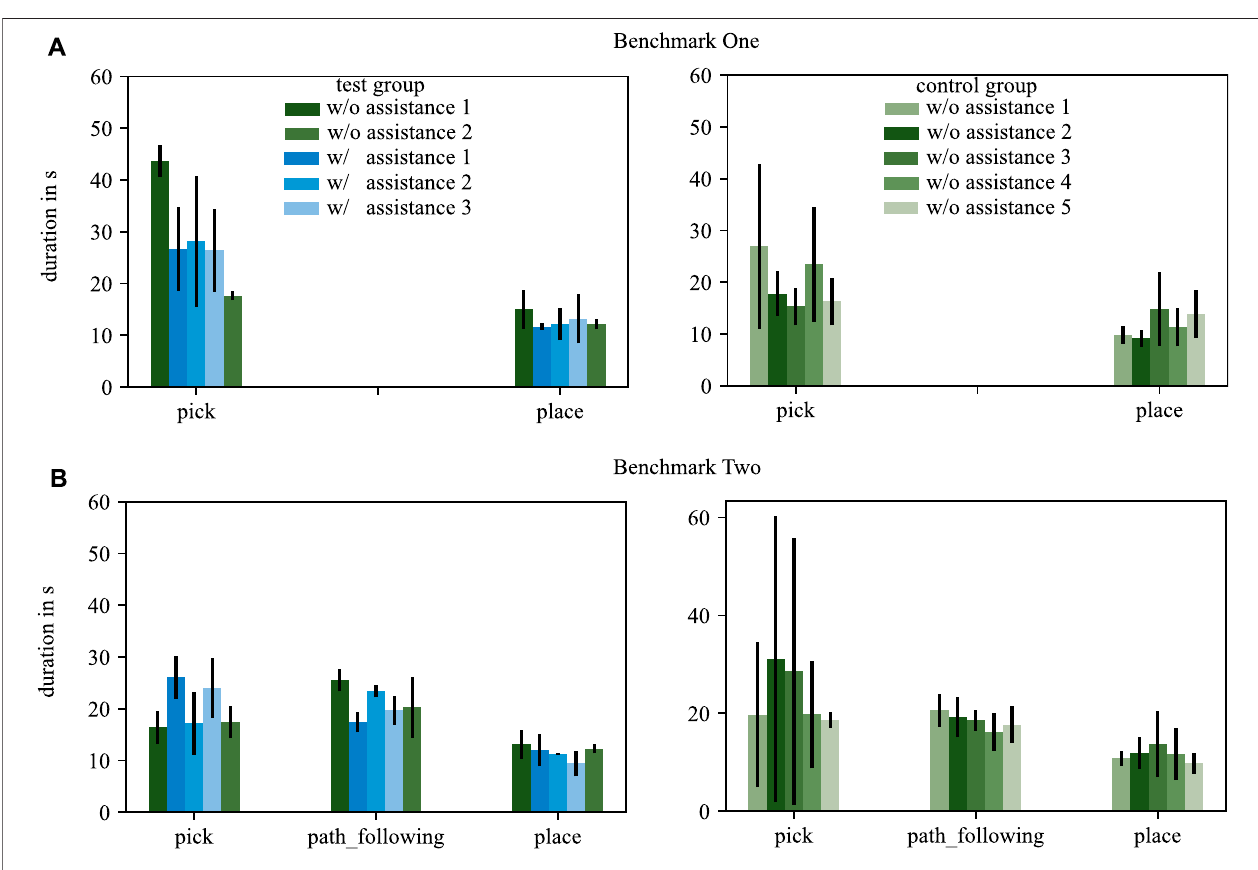
FIGURE7| Thedurationofeachtasksinbenchmarkscenarioone (A) andbenchmarkscenariotwo (B) aredepicted.Thetestgroupisdisplayedintheleftcolumn, the control group in the right column. Trials with assistance are shown in blue, trials without assistance in green. The standard deviation is depicted by black arrows.